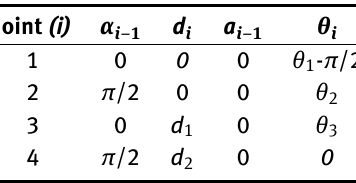
Table 1: Modified Denavit-Hartenberg